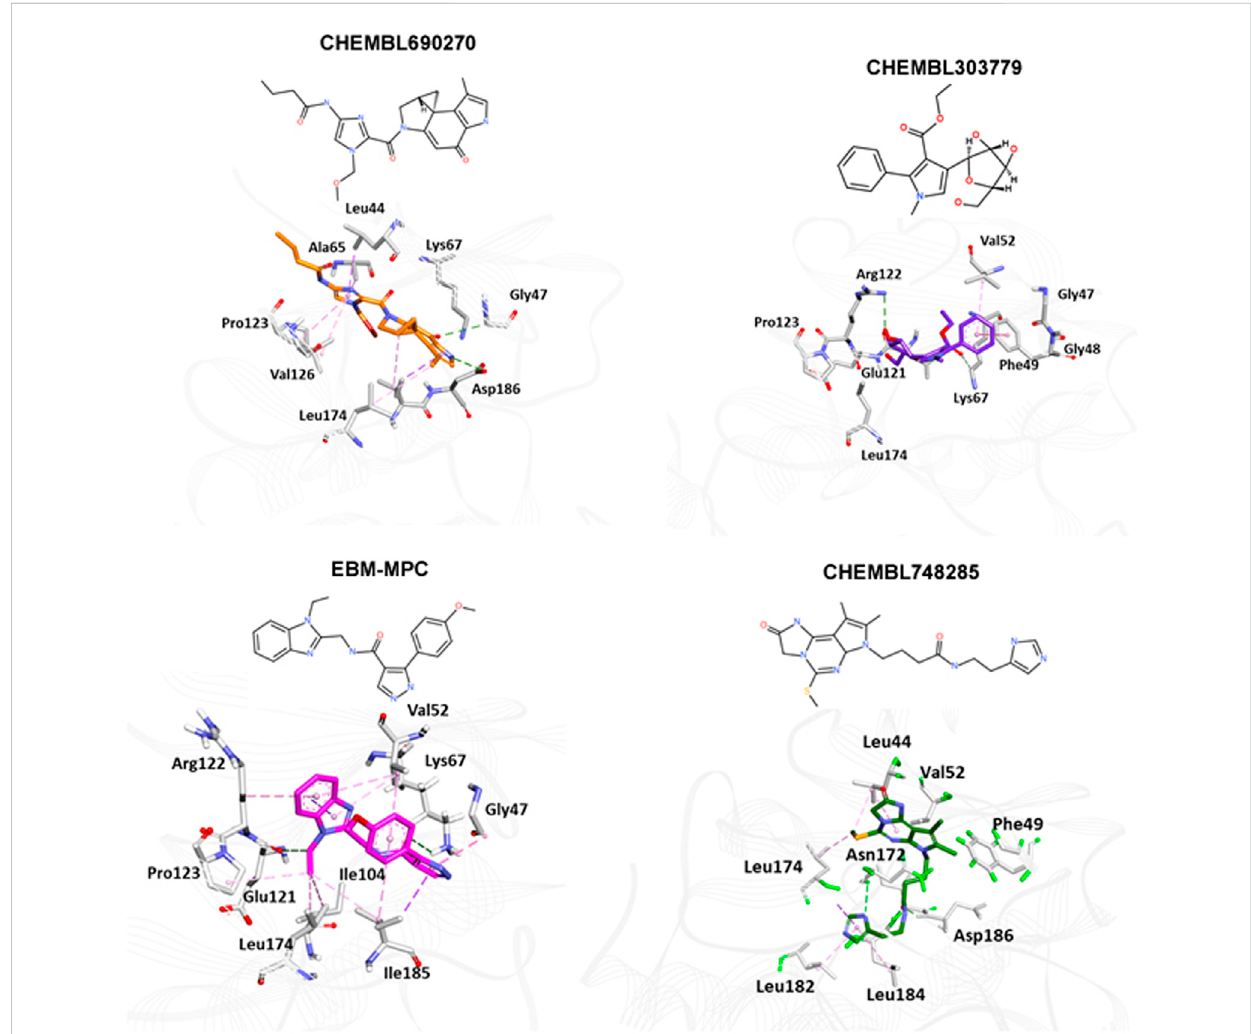
FIGURE 6 Binding mode analyses of selected compounds within the active site of PIM-1 kinase. Active site residues are shown as gray sticks; the protein backbone is shown as a light gray wire; hydrogen bonds are shown with a green dashed